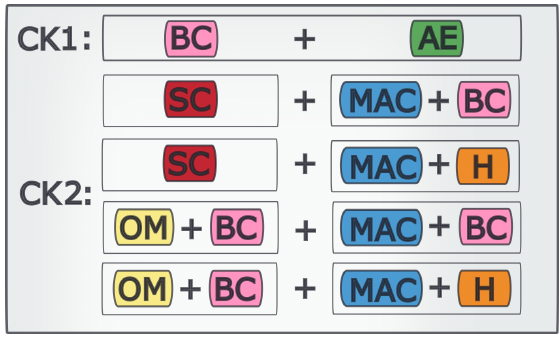
Figure 2. Summary of Crypto